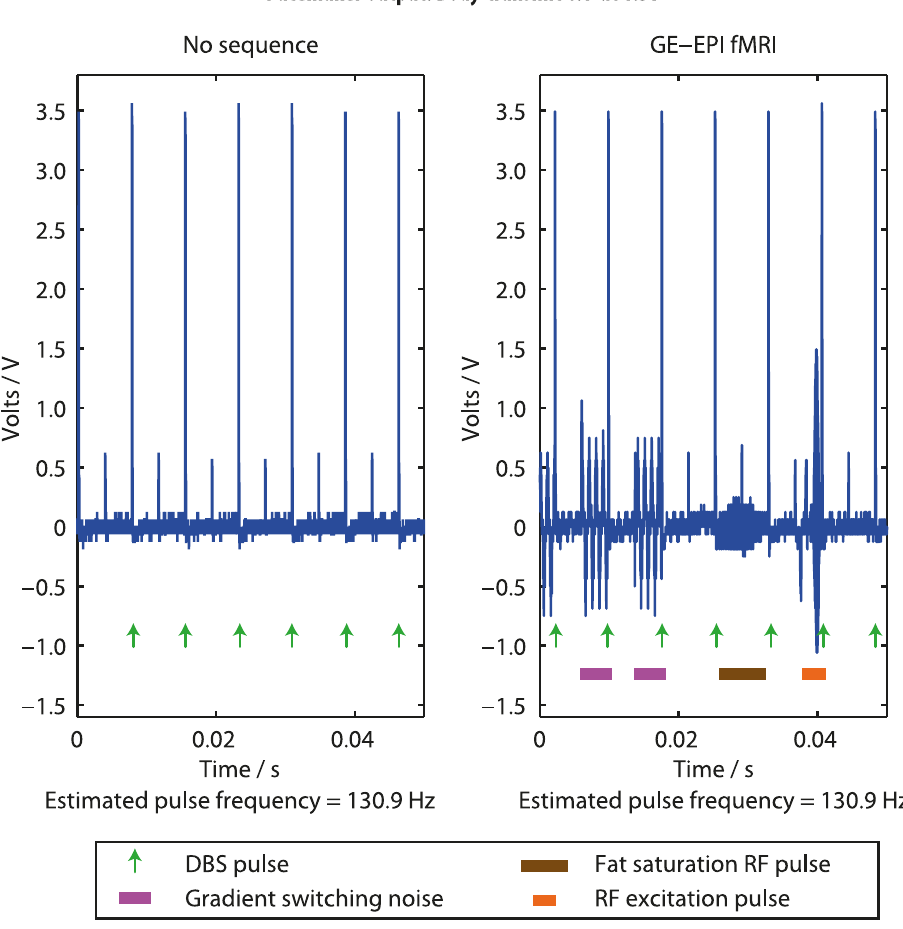
Fig 8. The implantable pulse generator voltage output during a typical GE-EPI fMRI